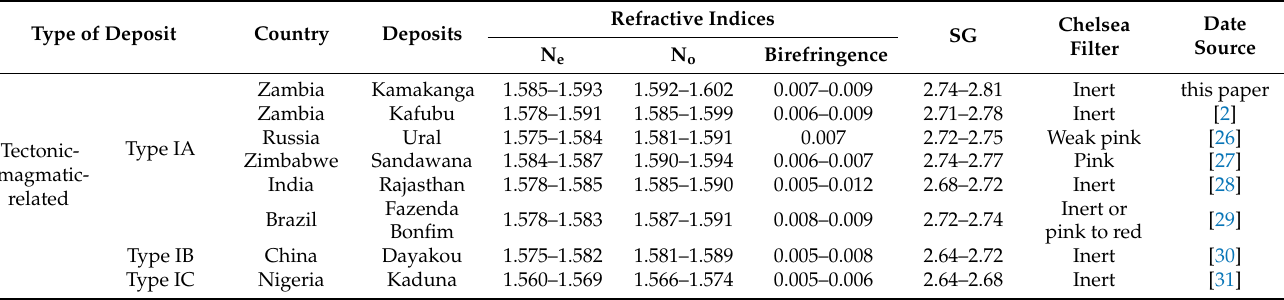
Table 3. Gemological properties of emeralds from various sources.